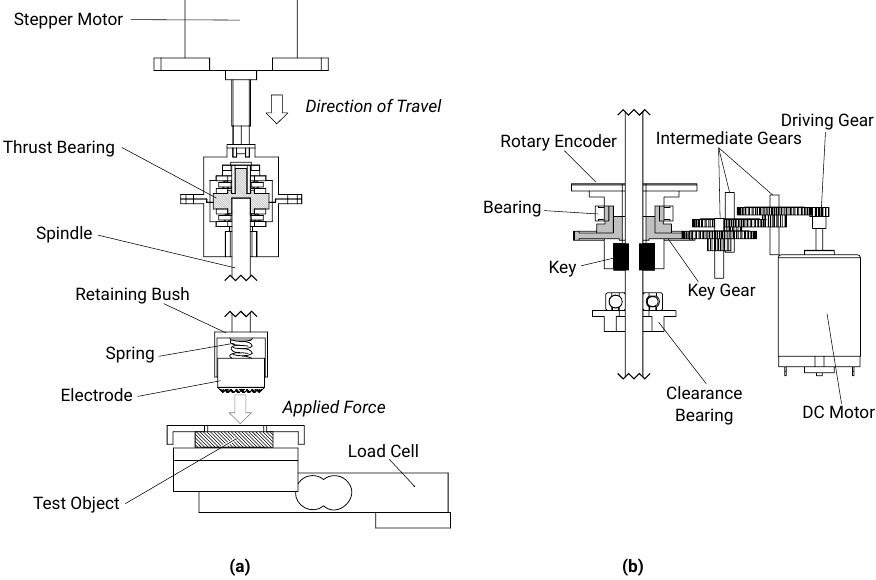
Figure 3. Mechanical components of abrasion characterisation test rig ( a ) applied force control via linear stepper motor, compliant element and load cell ( b ) rotation speed and position control via DC motor, transmission system and rotary encoder.